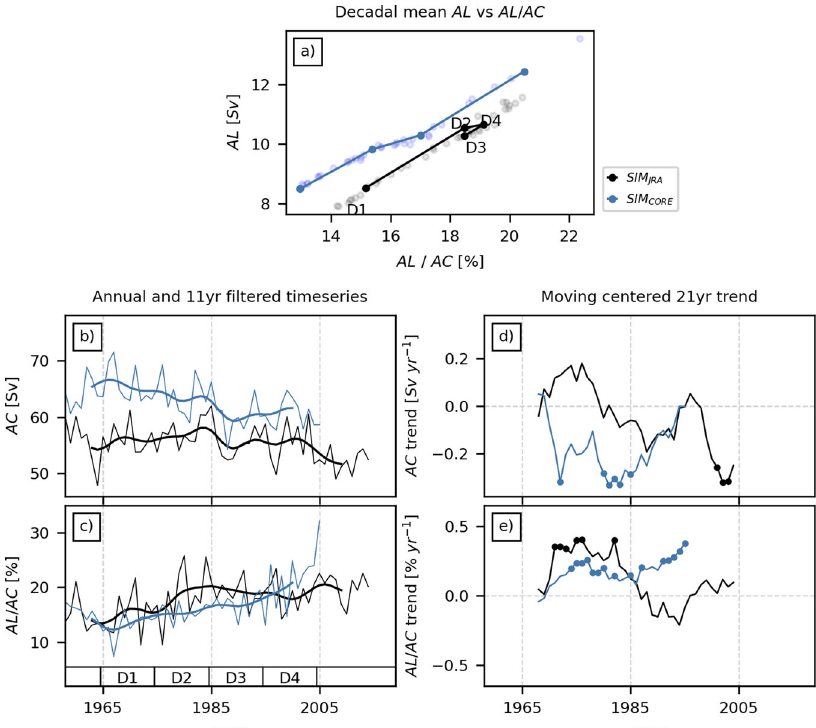
Fig. 5 Decadal trends in Agulhas leakage (AL) are largely decoupled from changes in the Agulhas Current (AC) and mainly represent a changing fraction of AC waters entering the South Atlantic (AL/AC). a Decadal mean AL vs AL/AC as simulated in SIM JRA (blue) and SIM CORE (black) (AL LA from Fig. 2a and AL/AC from panel c of this fi gure); decadal means for all possible averaging periods between 1958 and 2005 (overlapping simulation period SIM CORE and SIM JRA ) are displayed by semi-transparent dots, decadal means for subsequent periods D1 (1965 – 1984) to D4 (1995 – 2004) are marked by solid connected dots. Simulated annual (thin lines) and sub-decadally fi ltered (thick lines, 11 yr Hamming window) ( b ) AC and ( c ) AL/AC timeseries. d , e Moving centered 21 yr linear trends for timeseries in panels b and c of this fi gure (dots mark values that are signi fi cant according to student ’ s t -test and 95% con fi dence